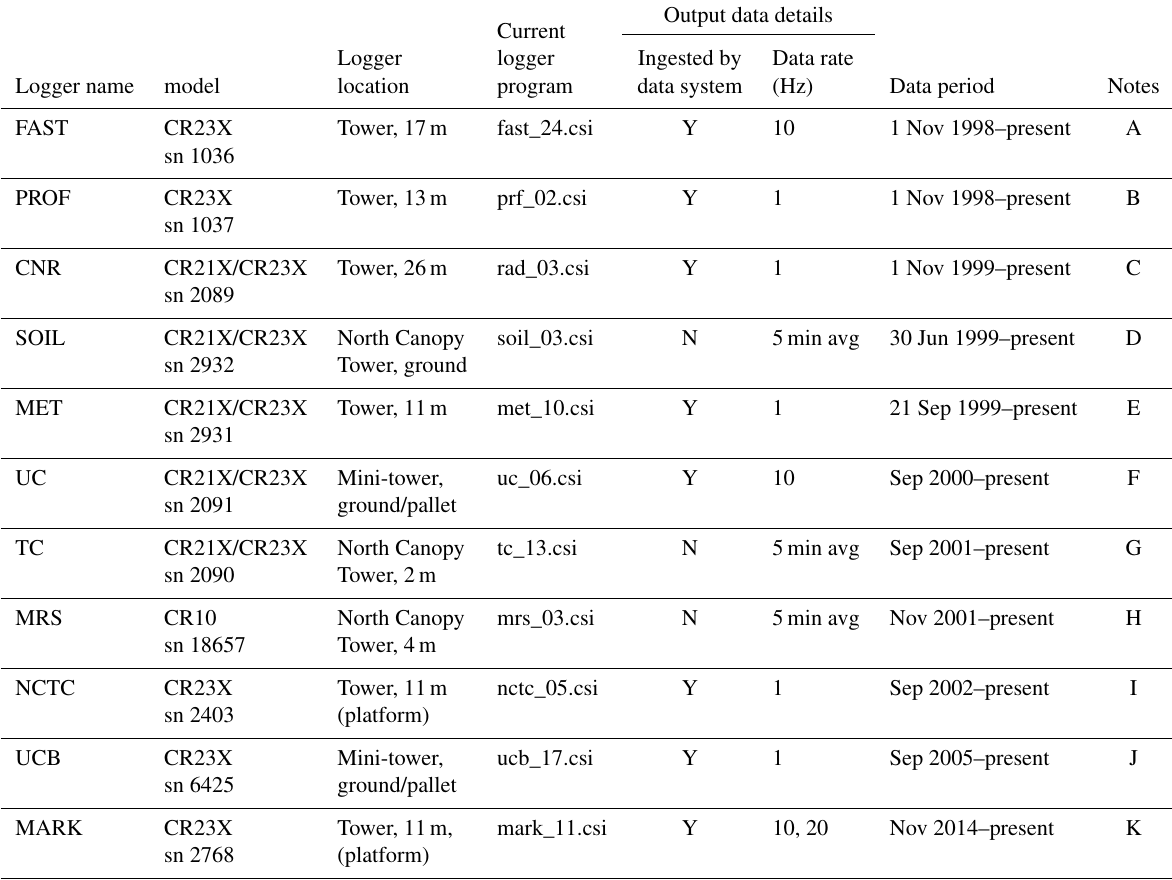
Table 2. Campbell Scientific data loggers used at the US-NR1 AmeriFlux site. The loggers are listed by the approximate date they were installed on the tower. At the start of the project (1 November 1998), three data loggers were used (FAST CR23X, PROF CR23X, and CNR/LIGHT CR21X). Early in the project, CR21X data loggers were sometimes used in place of the CR23Xs (where appropriate, this is listed in the notes below). By the end of 2001, the CR21Xs were replaced with CR23Xs. The serial numbers and logger locations refer to the data loggers currently in use at the site. The logger programs are the latest version of the code (for example, fast_24.csi means there are 24 versions of the FAST logger program since this naming scheme was initiated). The SOIL, TC, and MRS loggers were not connected to the high-rate data